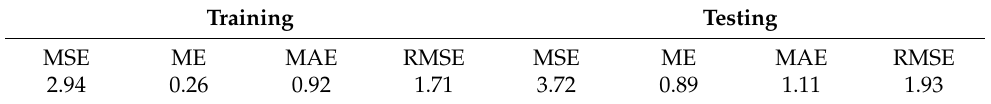
Table 5. Statistical indices of ANN with 6-6-4-2 topology combined with FOA.